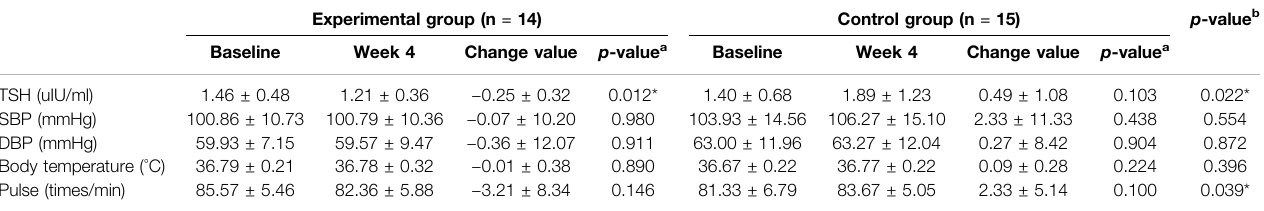
TABLE 7 | Changes in children ’ s TSH and Vital